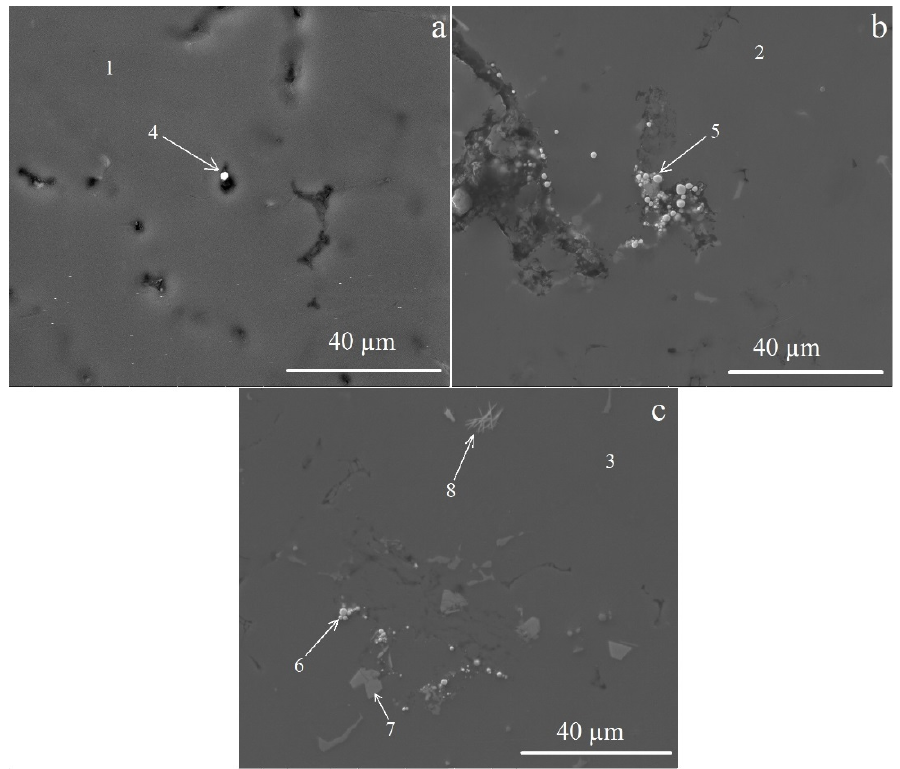
Figure 5. The SEM image of Al-Mg-W alloys: ( a ) Al-5Mg-0.3W, ( b ) Al-5Mg-0.5W, ( c ) Al-5Mg-0.8W. Table 1. Results of EDS analysis of Al-5Mg alloys (see Figure 5).